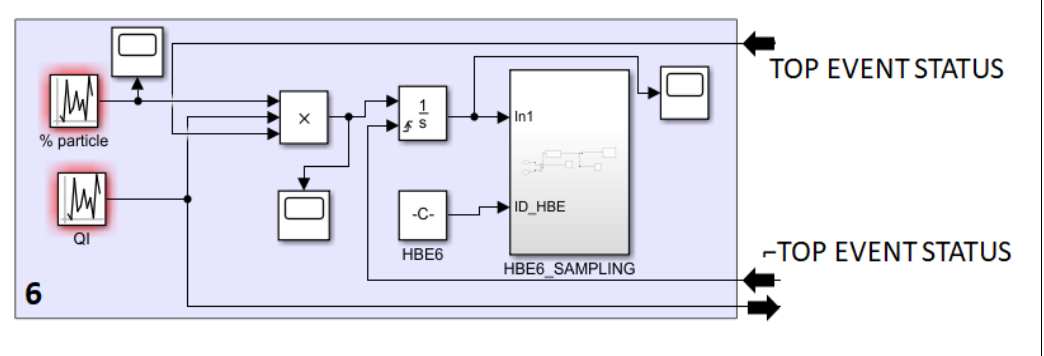
Figure 6. Simulink model of the HBE6 of the case study.